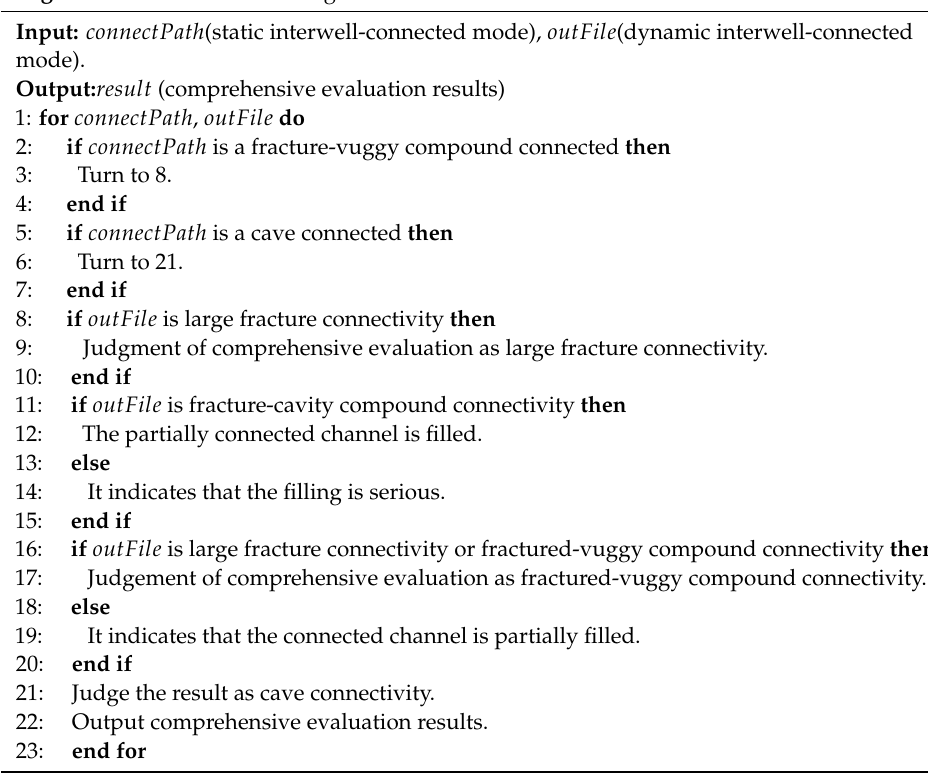
Algorithm 3: The evaluation